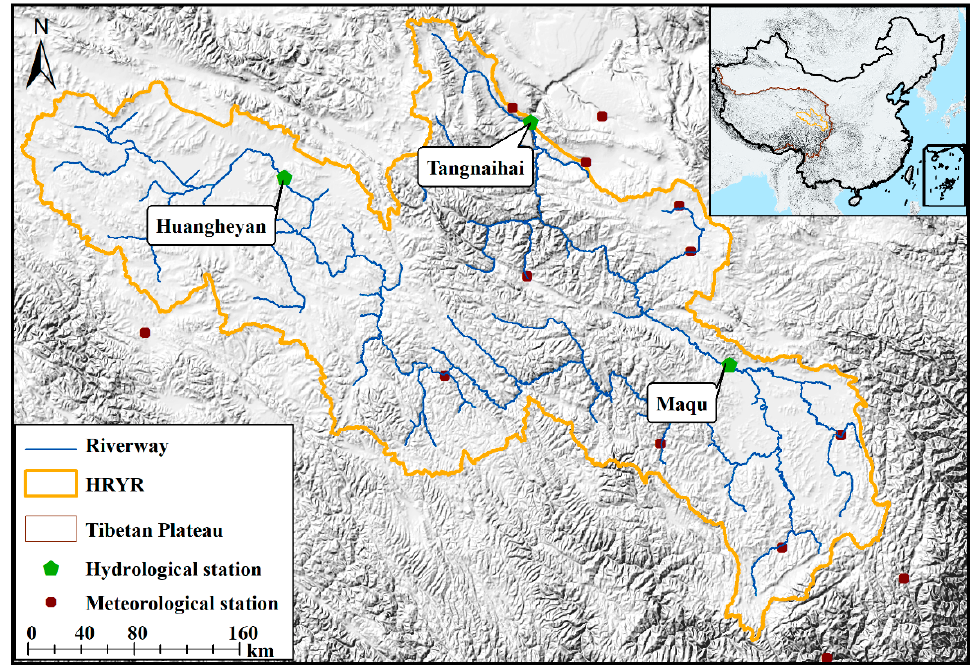
Figure 1. The location map of the headwater region of the Yellow River (HRYR) and selected hydroclimatic stations.